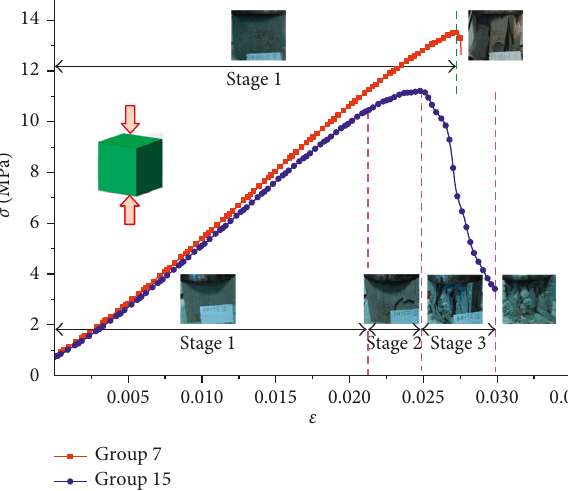
Figure 7: Destruction characteristics of the gangue concrete and the pure cement samples with the same water-cement ratio.